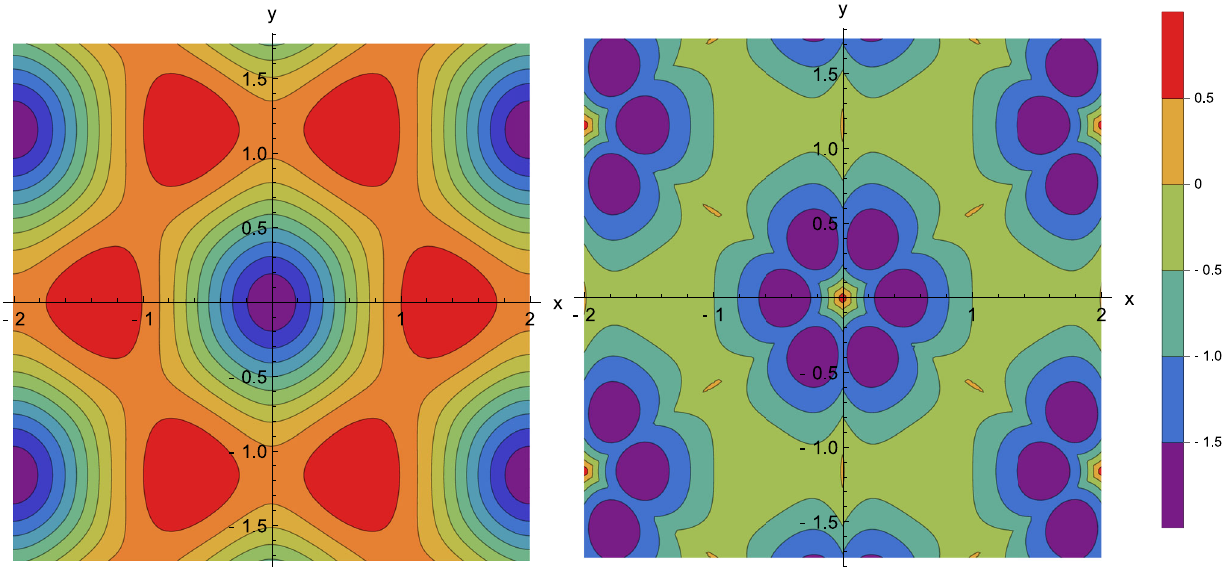
Fig. 1 Contour plot of the effective potential (14) for N f = 3, ξ = − 1 and g = 0 (left panel), g = 4 (right panel). The single minimum in the left panel is split into six in the right panel by the two loop contribution